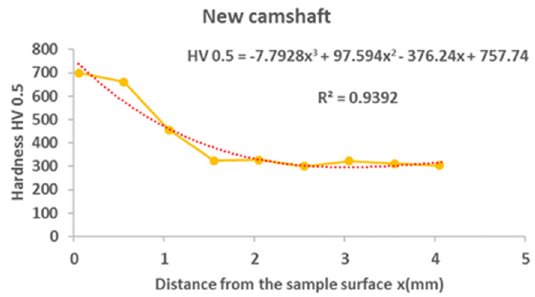
Figure 17. Regression analysis for a 3rd − order polynomial for the values of a new camshaft.